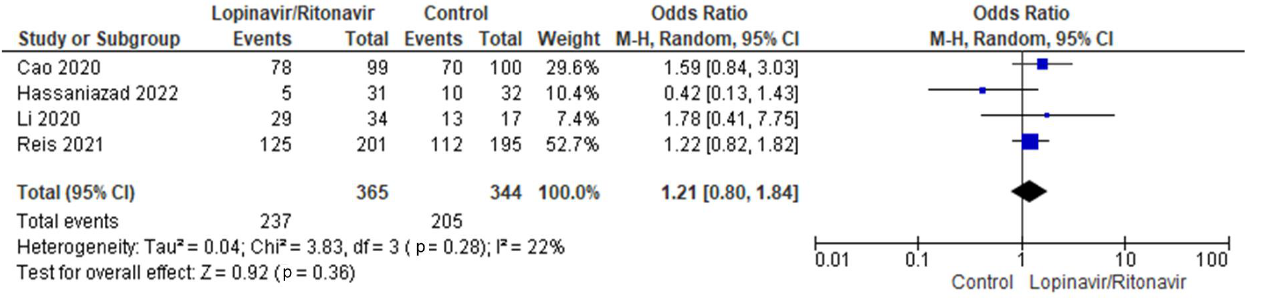
Figure 4. Forest plot analysis of clinical improvement. The sizes of the blue squares reflect the rela- tive weight of the individual trials. The combined point estimate is shown as a black diamond. The diamond and squares (together with the 95% CIs) located beyond the vertical line (indicating the unit value) show that a result was statistically significant.